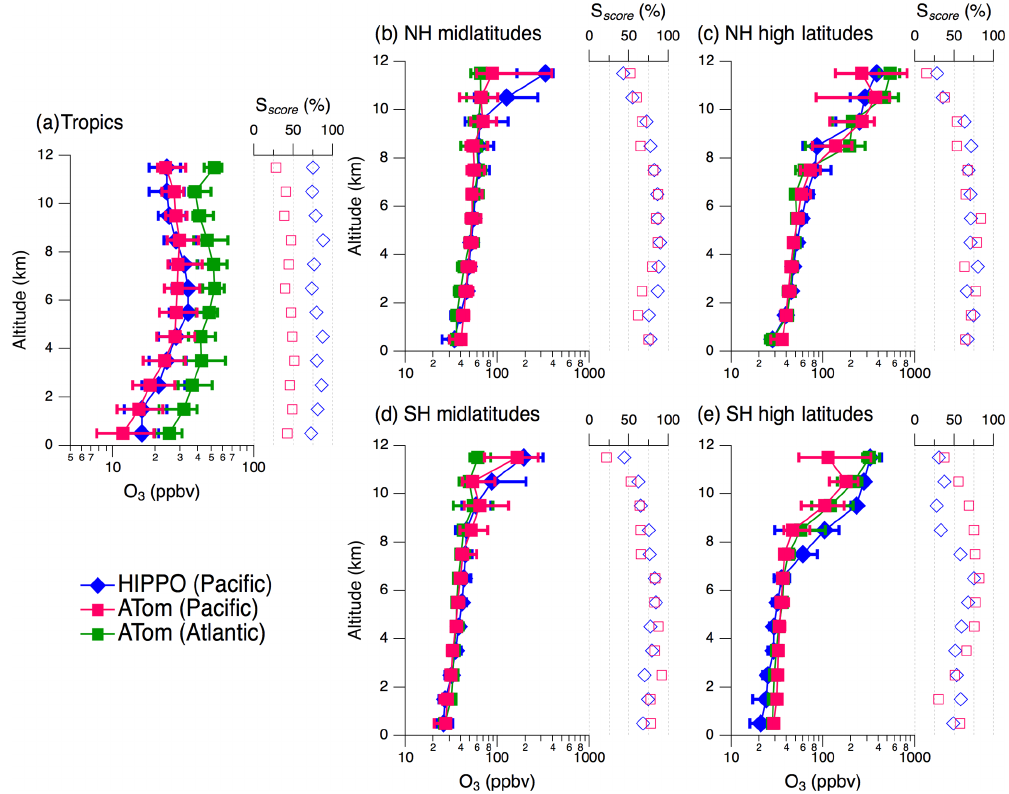
Figure 10. Vertically resolved O 3 distributions from 0 to 12km are plotted for the Atlantic (ATom in green) and for the Pacific (ATom in pink and HIPPO in blue). The five broad latitude regions correspond to the data parsing illustrated by Fig. 1. Markers indicate median O 3 , and bars are the 25th and 75th percentiles, per 1km altitude bin. Note the log scale on the x axis. S score values resulting from the comparison of HIPPO and ATom Pacific distributions are shown using blue diamonds, and values resulting from the comparison of ATom Atlantic and Pacific distributions are shown using pink squares.